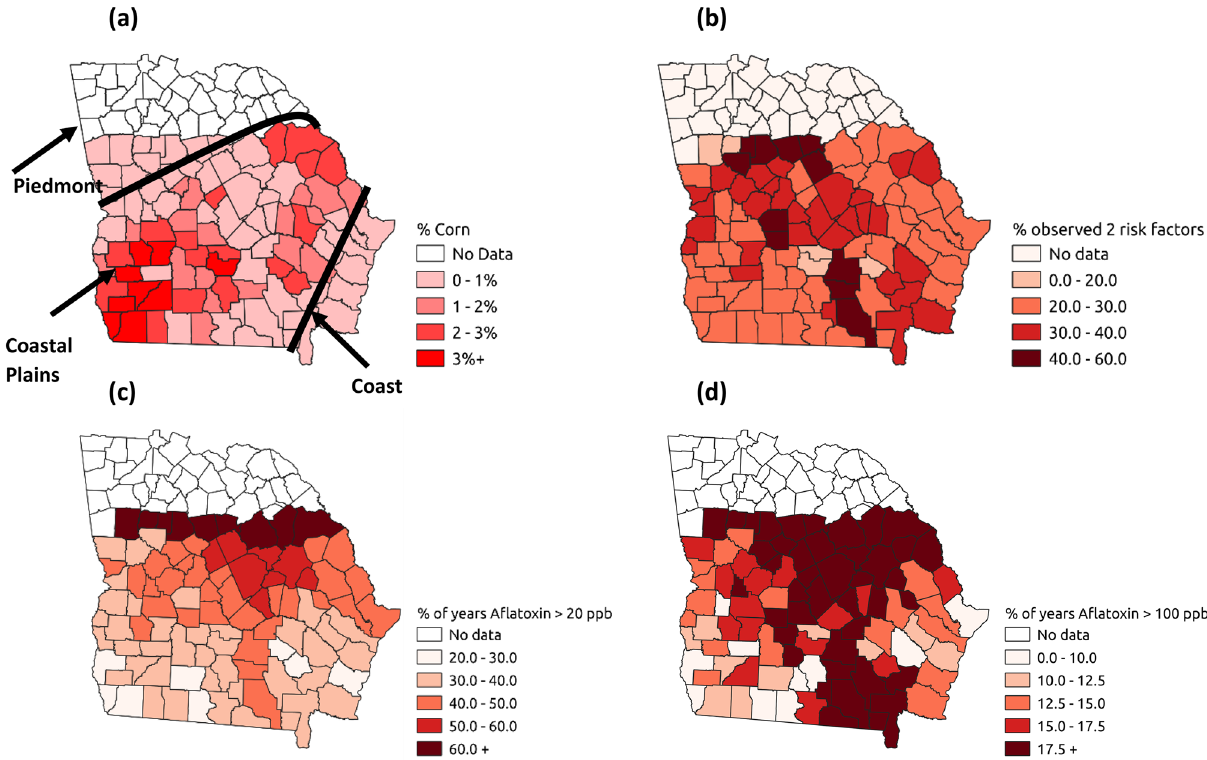
Figure 1. County maps of Southern Georgia, USA showing: (a) % Corn growing area and physiographic regions, (b) % observed two weather risk factor thresholds exceeded 1980–2004, (c) % years with > 20 ppb Aflatoxins, (d) % years with > 100 ppb